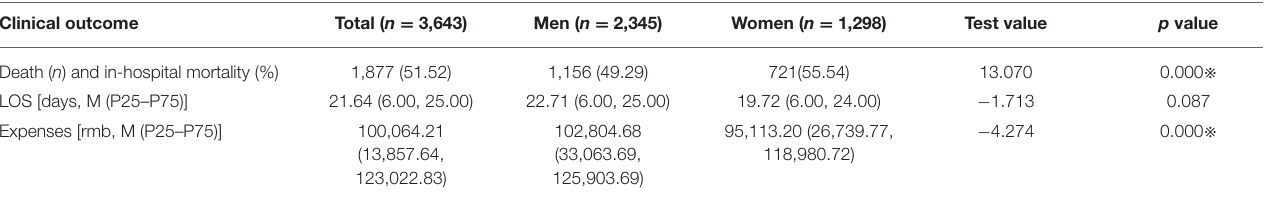
TABLE 3 | Sex-Based Differences in clinical outcomes of patients with septic